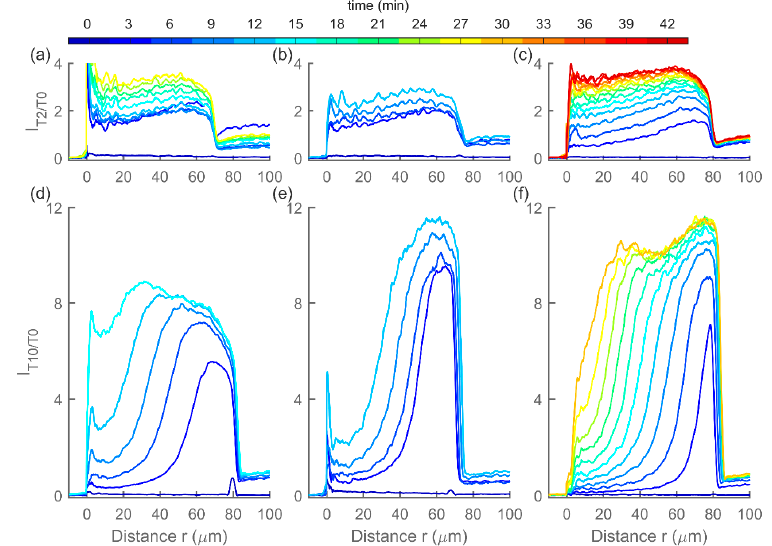
Figure 7. Spatiotemporal evolution of relative target (carboxyfluorescein-labelled MO- T2 or MO- T10 ) concentrations I T2/T0 and I T10/T0 after exposure of MO hydrogels to the target MO solution at approximately t = 0. ( a – c ) Spatiotemporal hydrogel response to T2 for individually prepared hydrogels. A profile is plotted for every third minute. ( d – f ) Spatiotemporal hydrogel response to T10 for individually prepared hydrogels. A difference in the spatiotemporal distribution pattern can be seen for the two different toehold lengths of the targets. While target T2 is filling up the hydrogel almost uniformly throughout its volume, target T10 first saturates the outermost layer of the hydrogel, leading to a sharp concentration change in the hydrogel and this boundary then shifts further towards the center of the hydrogel as each new layer becomes saturated with the T10 target. This difference suggests that similarly to toehold-mediated strand displacement of DNA [25], the dissociation constant strongly depends on the length of the toehold also for MOs, with the dissociation constant of T2 being larger than that of T10 . T10 binds strongly to the SB duplex and does not readily dissociate, which prevents the targets from penetrating far into the hydrogel before all the available binding sites within the outer layer are occupied. On the other hand, T2 which dissociates much more easily is quickly released after binding and diffuses further into the hydrogel before another binding occurs. DNA hydrogels were also exposed to DNA targets (DNA- T2 and DNA- T10 ) and imaged using CLSM (Figure 8). Compared to MOs, DNA hydrogels are swelling slower and exhibit a steeper concentration gradient moving inside the hydrogels, both in case of T2 and T10 targets. Unexpectedly, the concentration is seen to be increasing in the part right of the moving wavefront also for DNA- T10 , instead of quickly reaching a plateau, as was observed in the case of MOs. This behavior cannot be explained by the association, dissociation, and crosslink opening processes as described in the reaction–diffusion model and suggests another phenomenon taking place in these hydrogels. Additional experiments mapping effects of toehold molecular parameters are also reported elsewhere [24,42]. However, an explicit comparison between the various sets of data is challenging due to differences in concentrations of immobilized dsDNA crosslinks and possible effects of the various fluoroprobe labels.